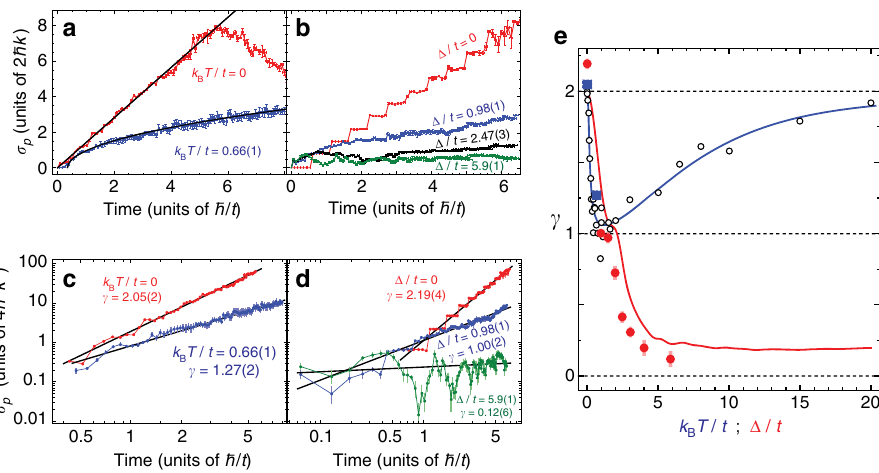
Fig. 3 Expansion dynamics in static and dynamical disorder. a Momentum width σ p (standard deviation, units of 2 ħ k ) vs. evolution time ( τ , units of ħ / t ) for random static tunnelling phases ( red data , labelled k B T / t = 0) and random dynamical tunnelling phases ( blue data , labelled k B T / t = 0.66(1)). Overlaid as ffiffiffi p ffiffiffiffiffi p (cid:4) (cid:5) τ 2 and diffusive transport ( σ p ¼ 2 τ , shifted by 0.35 ħ / t ). b Momentum-width dynamics for the black lines are the predicted dynamics for ballistic σ p ¼ cases of static site-energy pseudodisorder and uniform equal-phase tunnelling. The data curves relate to disorder strengths of Δ / t = 0 ( red data ), Δ / t = 0.98(1) ( blue data ), Δ / t = 2.47(3) ( black data ) and Δ / t = 5.9(1) ( green data ). c Double logarithmic plot of the momentum variance ( σ 2 , in units of 4 ħ 2 k 2 ) for p the random phase data in a , fi t to the form V ( τ ) = ατ γ . The fi t-determined values of γ are shown for each case. d Double logarithmic plot of the momentum variance for the static disorder data in c , along with power-law fi ts and extracted expansion exponents γ . e The fi t-determined expansion exponents γ plotted vs. the effective annealed disorder temperature ( k B T / t , blue squares ) for dynamical disorder and vs. the disorder strength ( Δ / t , red circles ) for static pseudodisorder. The solid blue line is a fi t to numerical simulations ( open black circles ) for the case of dynamically varying phase disorder, and the solid red line represents numerical simulations for static pseudodisorder. All error bars denote one